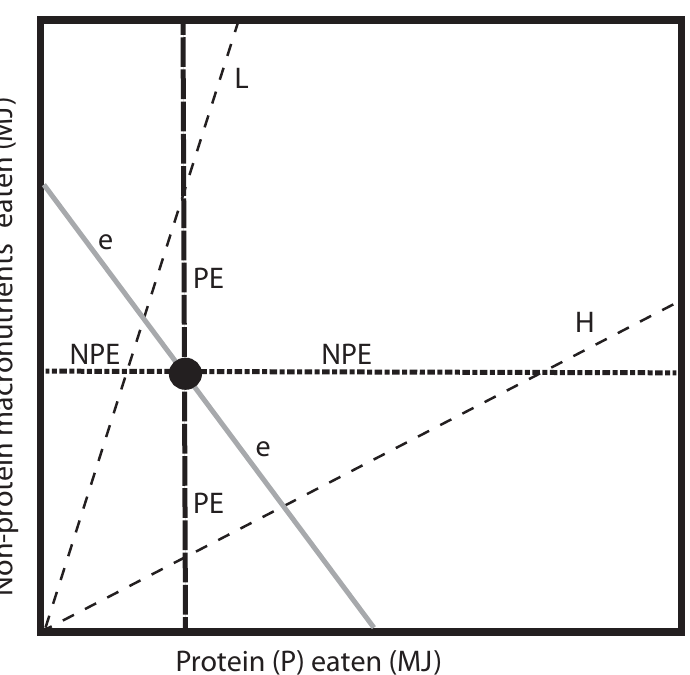
Fig 1. Logic of the experimental design under the Geometric Framework for nutrition (GF). The model shows potential outcomes when animals are fed diets containing different ratios of protein versus non-protein macronutrients (non-structural carbohydrates, lipids and fermentable fibers) [32]. Dashed radials ( “ food rails ” ) represent the nutritional balance of food items, here exemplifying two contrasting foods that are either relatively high in protein and low in non-protein macronutrients (H) or vice versa (L). When study subjects are given both of these complementary food items ad libitum , they are allowed to reach any point within the macronutrient space between the two food rails. Their intake during such a free-choice situation ( “ buffet ” ) indicates their preferred target point in macronutrient space (black dot) and provides a baseline for comparison with the rest of the experiment (the location of the target point in this figure is not empirically derived). If the moose ’ intakes during buffets fall along line H, the strategy of protein maximization is indicated; if their intakes fall along line L it would indicate energy maximization; and if they combine the foods in specific non-random proportions the results would indicate macronutrient balancing (the black dot). Combined results from both buffets and periods when the moose are restricted to only one of the two food types allow us to see how the animals balance over-eating the nutrient in high concentration against under- eating the nutrient in low concentration, relative to their target, i.e. their rule of compromise. This pattern could potentially show regulation of total energy ( e , grey isoline with slope of -1), or prioritization of protein energy (PE, black dashed vertical line), or prioritization of energy from non-protein macronutrients (NPE, black dotted horizontal line). (For a full description of the GF see [26,